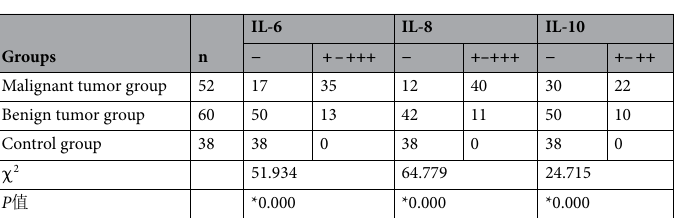
Table 3. The expression of IL-6 ， IL-8 and IL-10 in CMGTs and normal canine mammary gland tissues detected by immunohistochemistry. *denotes P < 0.05 compared with the control group.